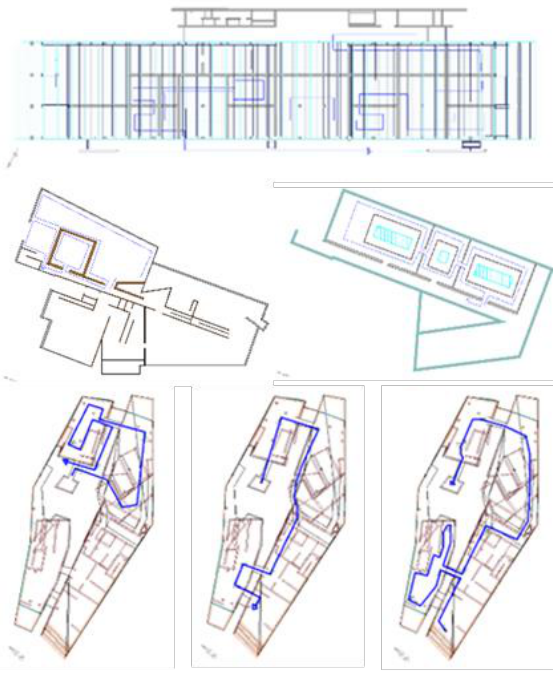
Figure 07 : the route plan